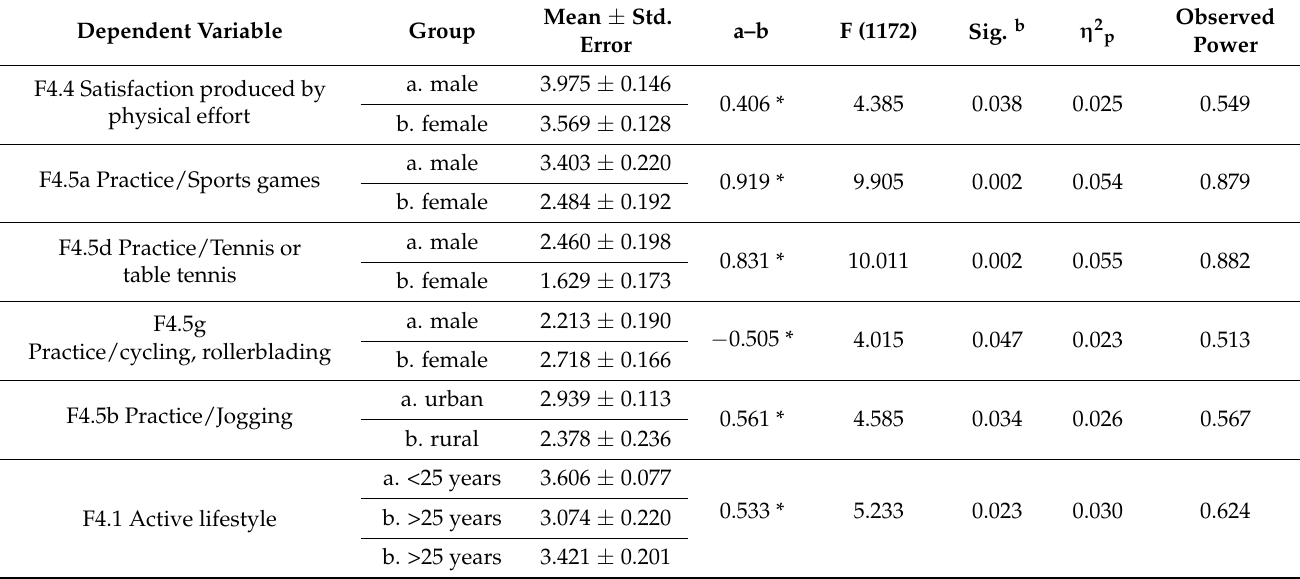
Table 9. The results of the univariate tests/ANOVA and the comparison in pairs of the average values at the level of the items for factor 4 (leisure sports activities).